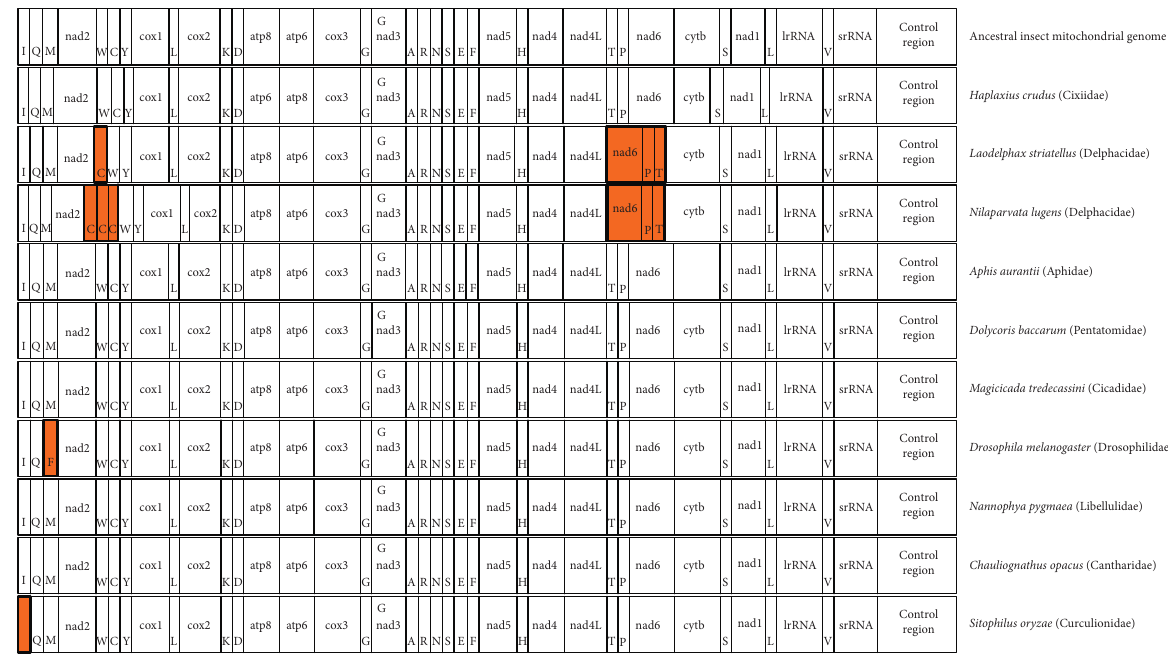
Figure 3: Linear map of the putative ancestral insect mitochondrial genome (top) compared to Haplaxius crudus and other insect species; orange � deviation from ancestral genome.